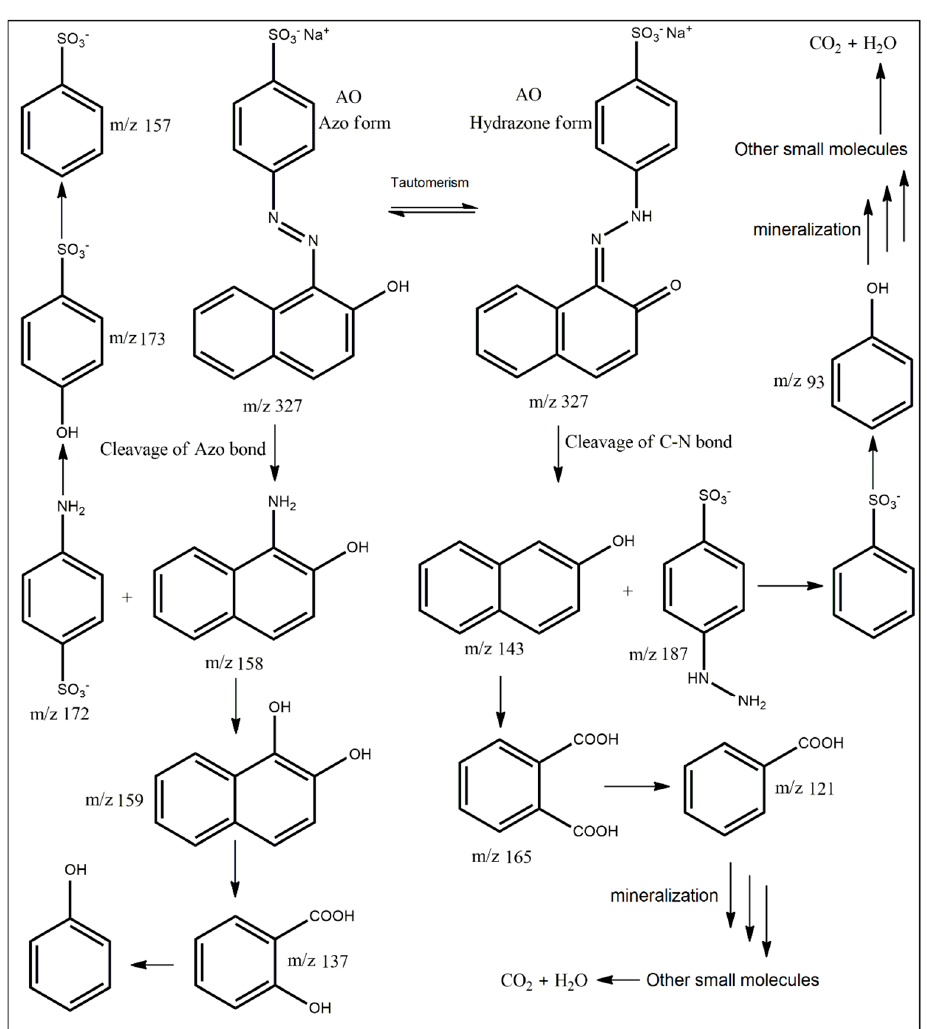
Figure 5. Possible intermediates formed in the AO degradation by 2 .